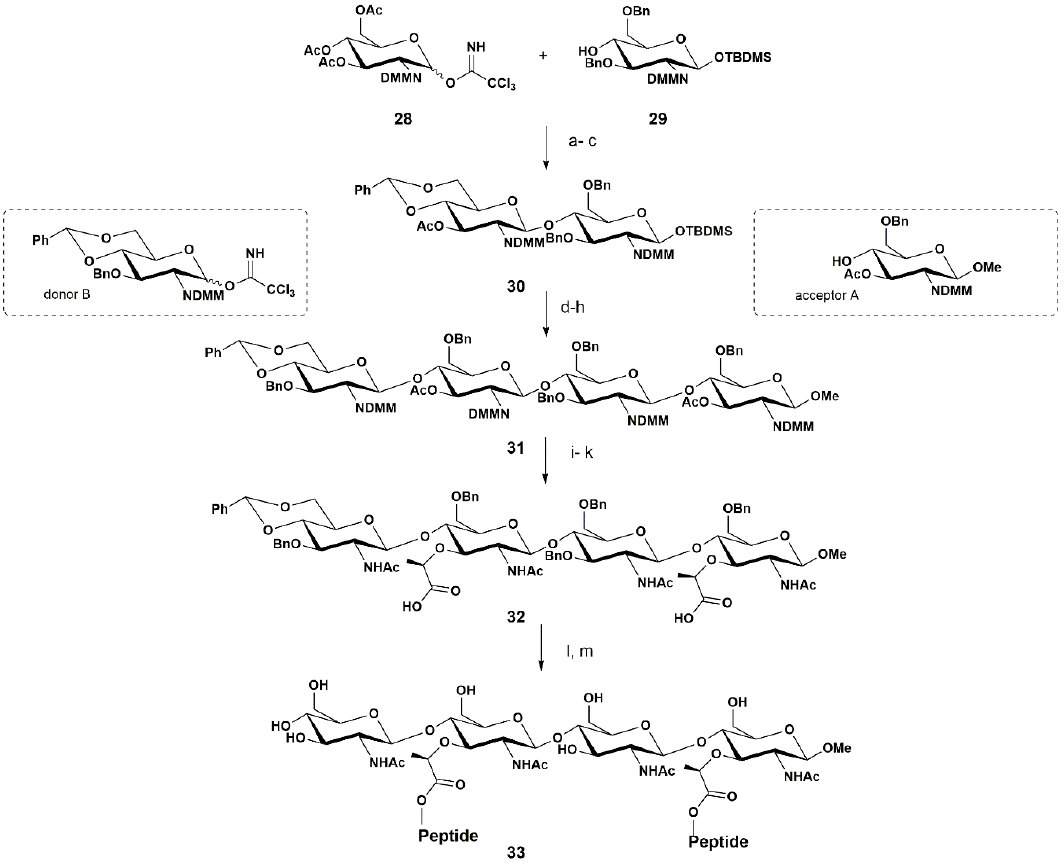
Scheme 5. Synthesis of the tetrasaccharide with pentapeptides attached to NAM units, 33 ,